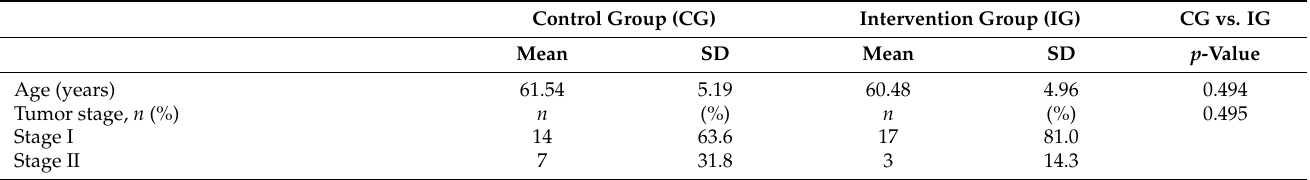
Table 1. Baseline characteristics and body composition of the Control Group (CG) and Intervention Group (IG) of the